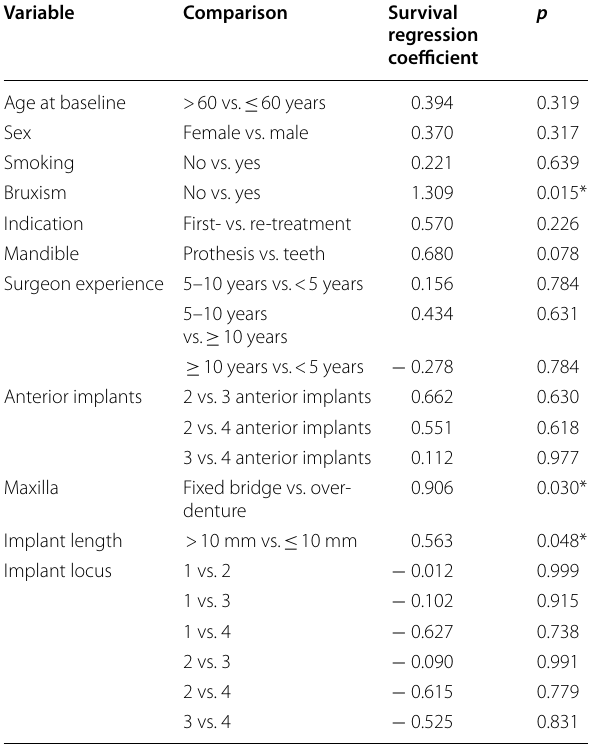
Table 7 Survival regression coefficient per